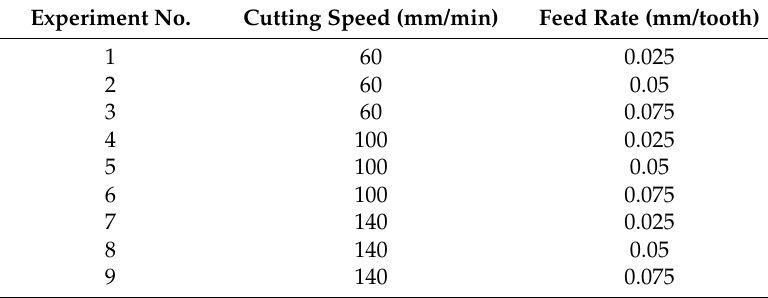
Table 2. Details of design of